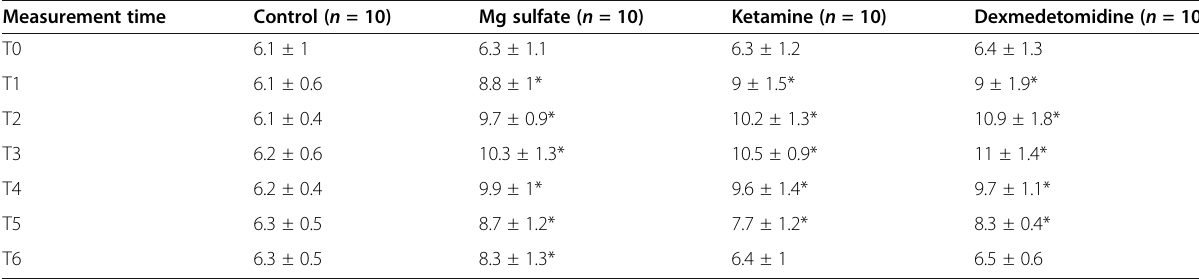
Table 1 Hot-plate test results of the study groups Measurement